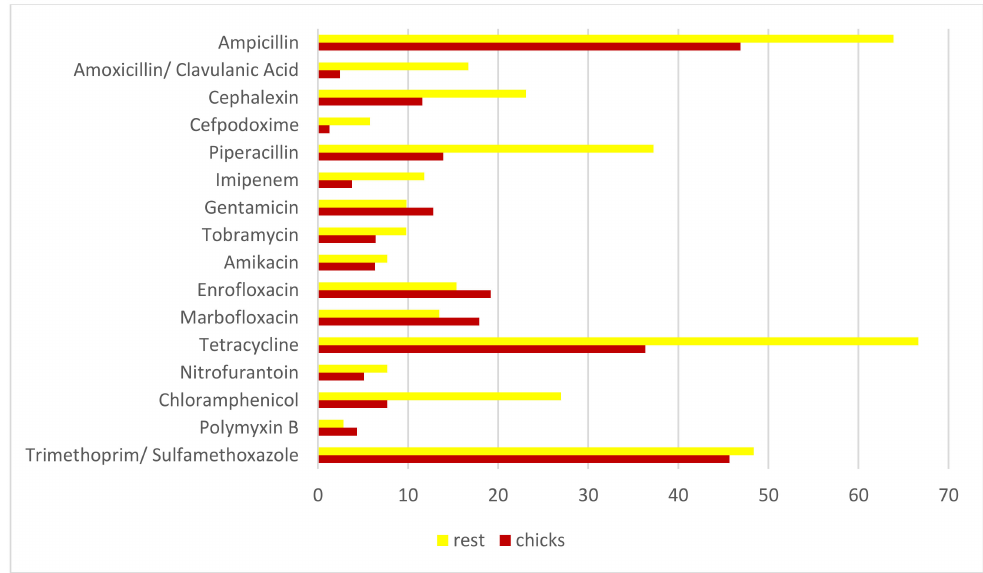
Figure 4. Di ff erences in the percentage of resistant between chicks in the nests and the rest of the of animals (adult and immature